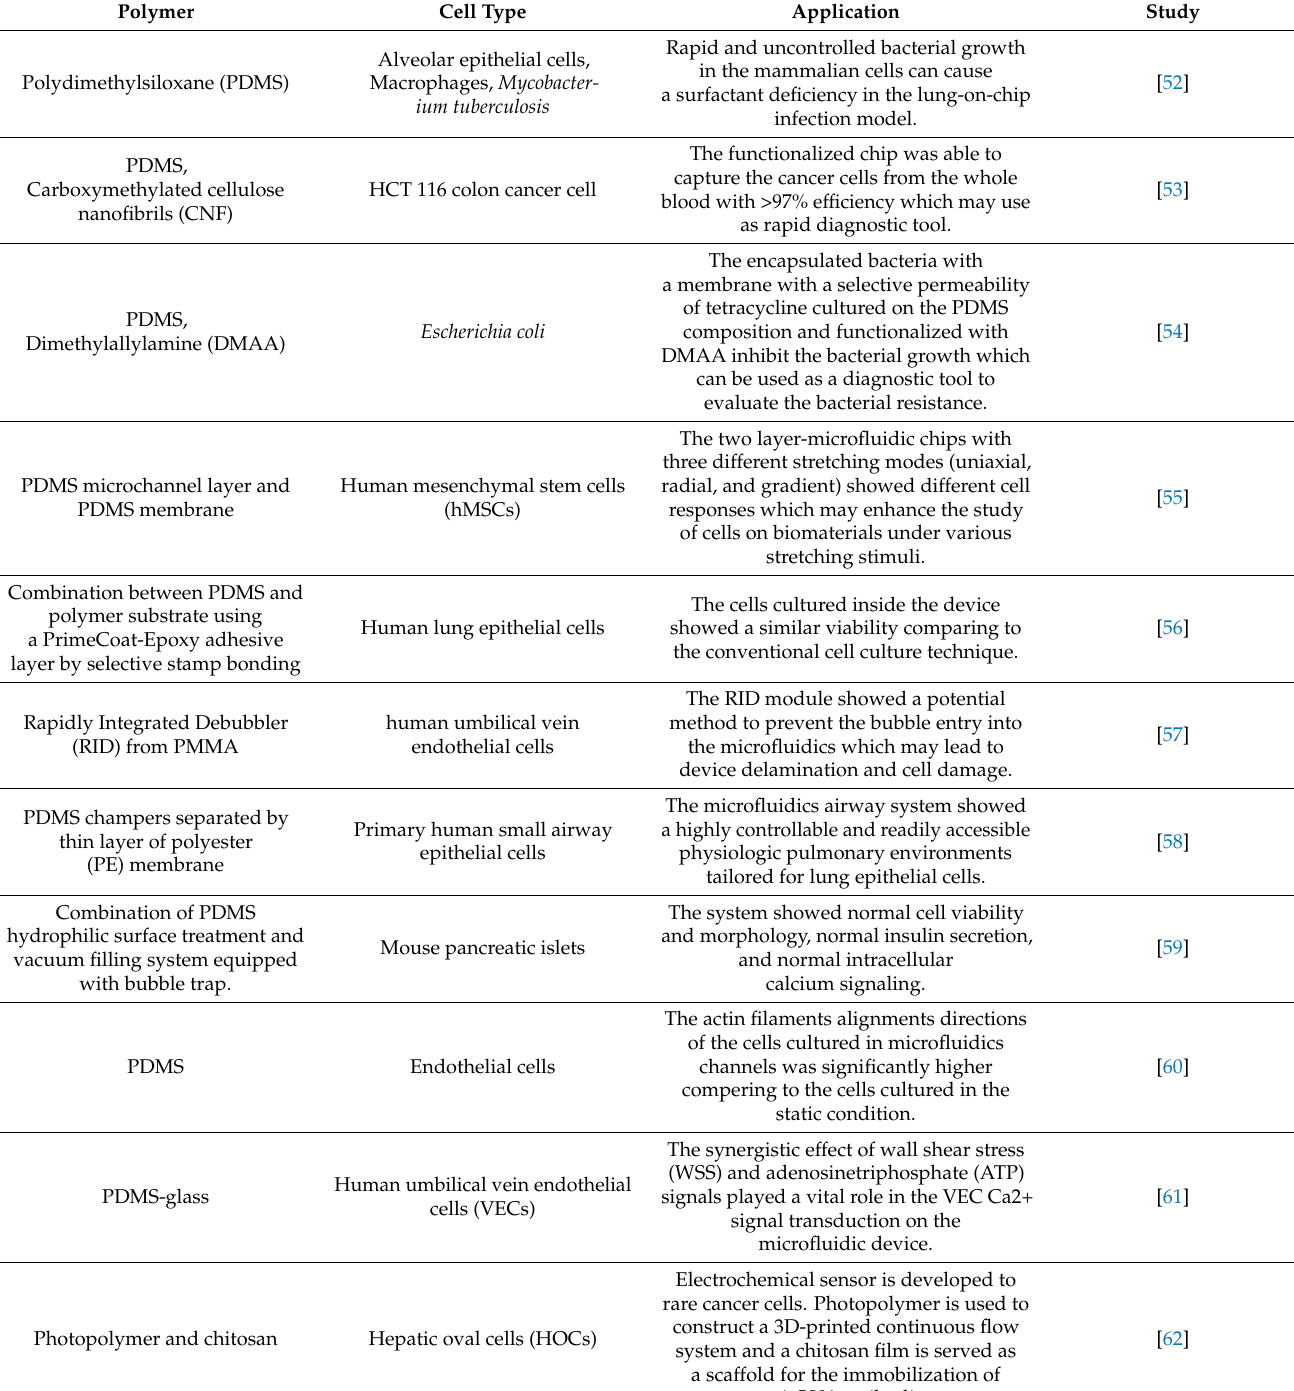
Table 2. Some studies using polymers for microfluidics devices for various biological